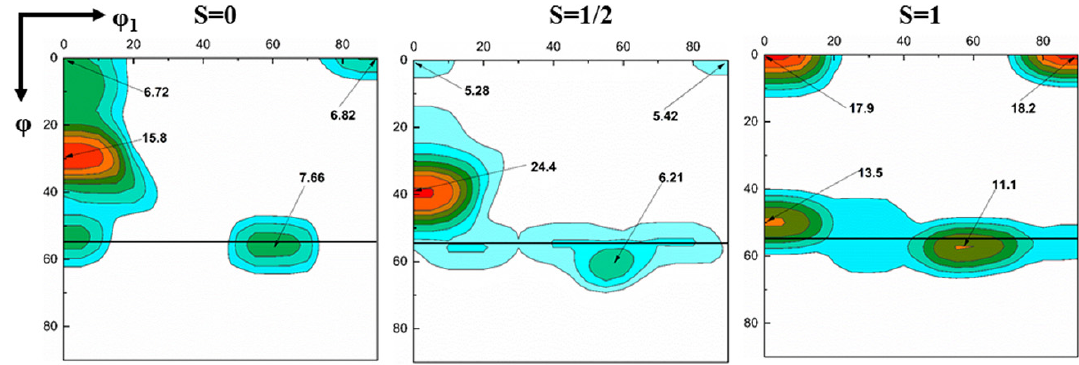
Figure 6. ϕ 2 = 45 ◦ sections of the ODF at di ff erent layers in the ASR cold-rolled sample. Figure 6. φ 2 = 45° sections of the ODF at different layers in the ASR cold-rolled sample.